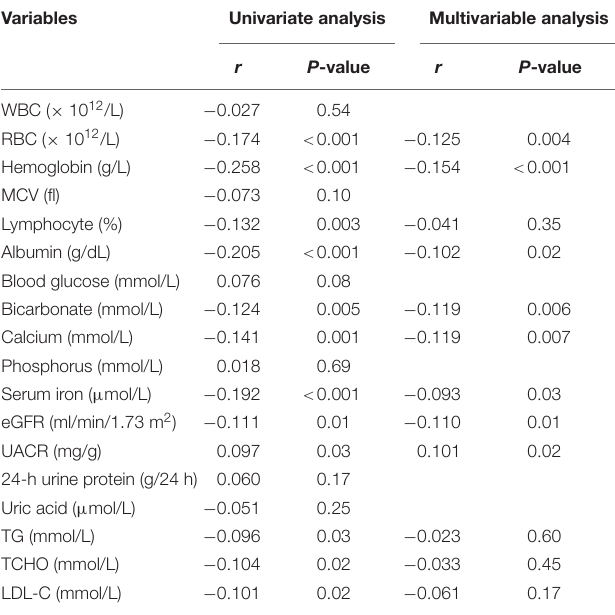
TABLE 2 | Correlations between baseline RDW and laboratory